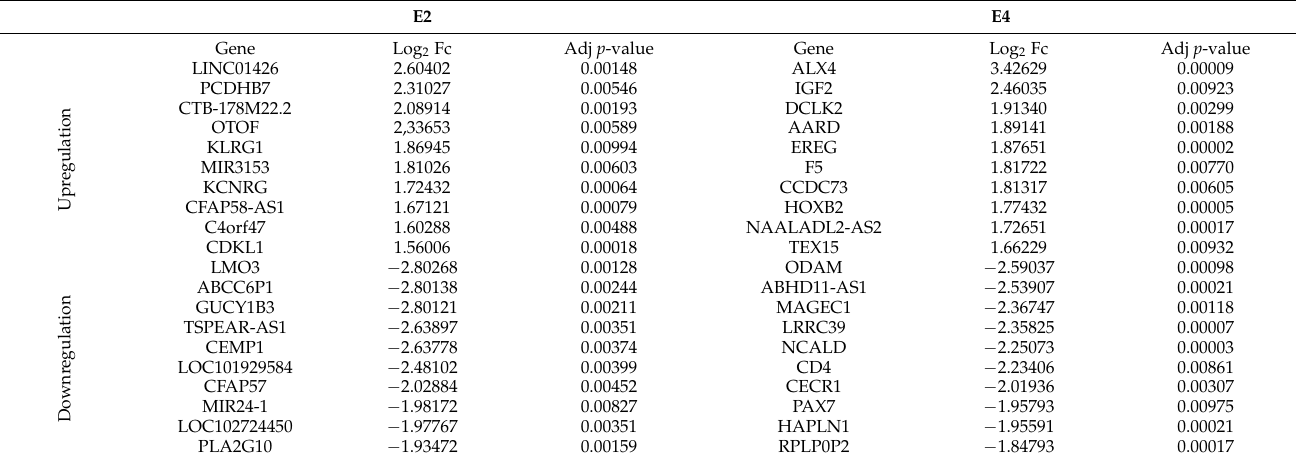
Table 1. E2- and E4-gene